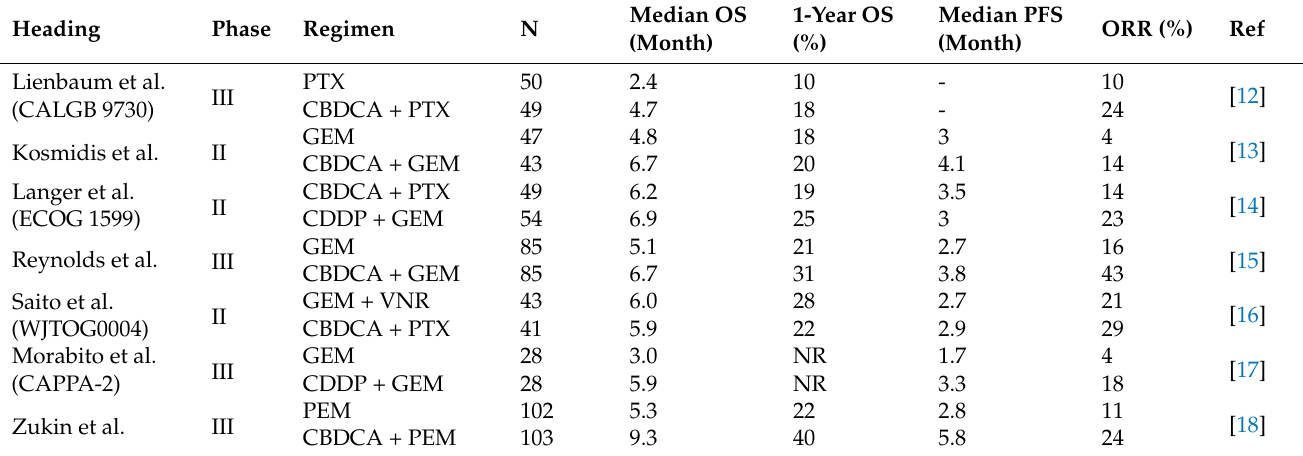
Table 1. Key randomized trials of cytotoxic chemotherapy for NSCLC with PS